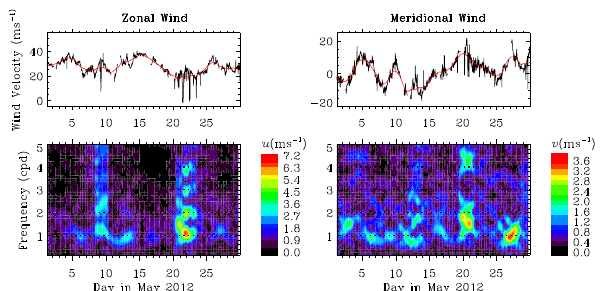
Figure 6. The zonal (left) and meridional (right) winds (upper) and their shifting spectra (lower) at 13.34km in May 2012. The 2-day averages of winds are denoted by red curves in the upper panel.